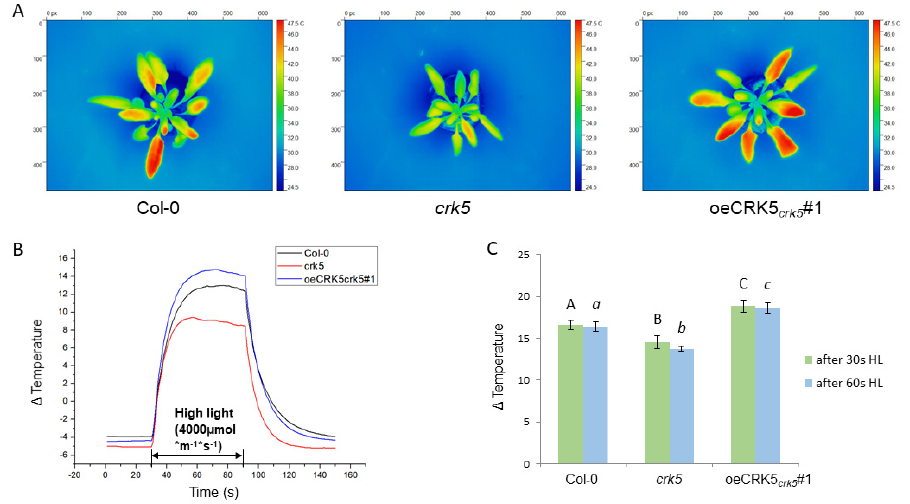
Figure 6. Analysis of foliar temperature under variable light conditions. ( A ) Thermograms showing whole rosettes of different Arabidopsis genotypes after 30 s high light (4000 µ mol photons m − 2 s − 1 ). ( B ) Plot showing dynamic foliar temperature changes under variable light conditions in comparison to the background—white surface on which plants were placed during the measurement. The white surface reflected the light, and its temperature increased by only 1,5C during high light exposure. The program was set as follows: 30 s of ambient light (150 µ mol photons m − 2 s − 1 ), followed by 60 s of high blue light (4000 µ mol photons m − 2 s − 1 ), followed by 60 s of ambient light (150 µ mol photons m − 2 s − 1 ). ( C ) Average leaf temperature changes after 30 s and 60 s of high light exposure. Data represent mean values of 4 different leaves from 5 plants ( n = 20). Statistical analysis was performed according to a t -test at level p < 0.05. Letters A, B, C and a, b, c above the bars indicate homogenous groups.